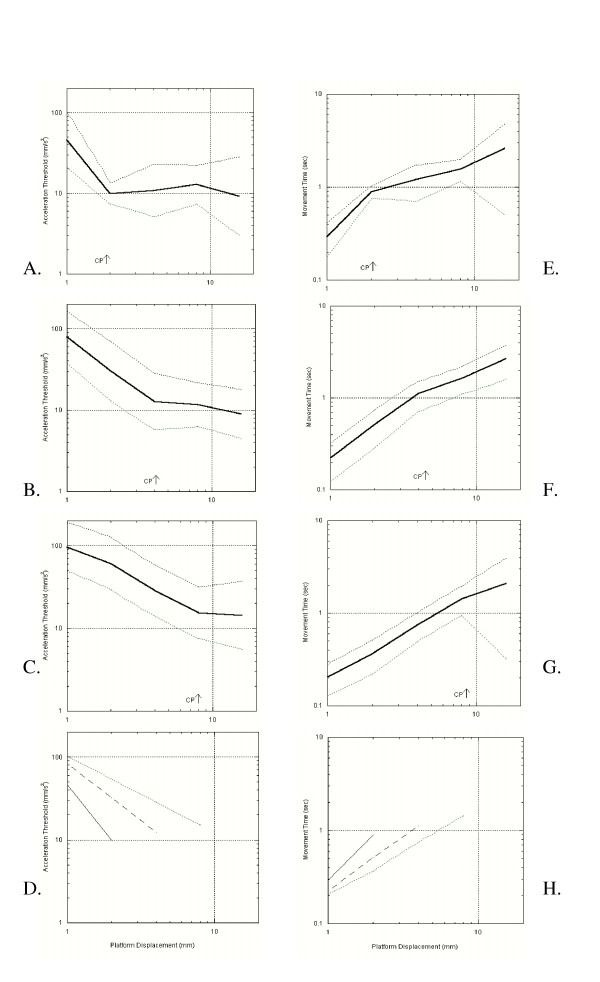
A- D: Geometric Mean and Standard Deviations for lateral acceleration detection thresholds versus Displacement for three groups. Bold lines indicate mean, while thin lines above and below represent the mean +/- 1 geometric standard deviation A: Young adult averages and standard deviations B: Healthy older adults averages and standard deviations C: Diabetic older adults averages and standard deviations. D: Modeled negative power law relationships for healthy young adults (solid line), healthy older adults (long dashed line) and diabetic older adults (short dashed line). Only the linear portion of each curve before the critical point was modeled. Thresholds for displacements after the critical point were the same in all subjects in all groups (~10 mm/s2). E-H: Geometric Mean and Standard Deviation for Movement time versus deisplacement. E: Young adult F: Healthy older adults G: Diabetic older adults. H: Modeled negative power law relationships for healthy young adults (solid line), healthy older adults (long dashed line) and diabetic older adults (short dashed line). Only the linear portion of each curve before the critical point was modeled.